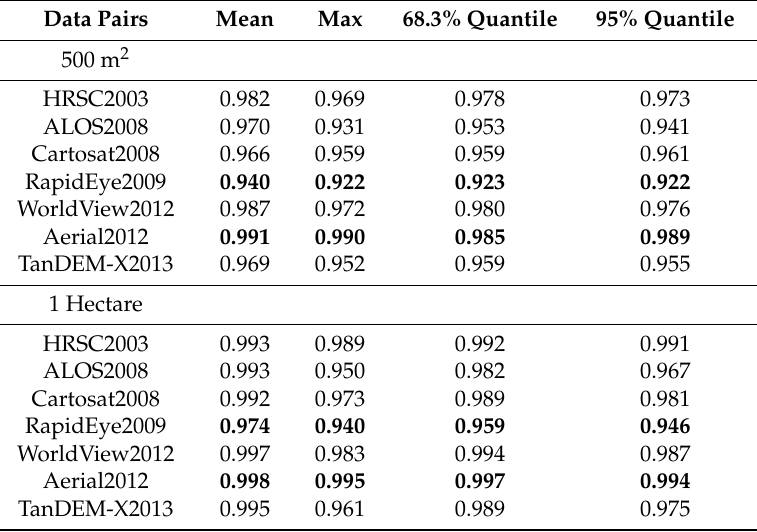
Table 3. Correlation coefficients between height metrics of image- and LiDAR-derived DSMs for 500 m 2 and 1 ha grid cells (highest and lowest values are marked in